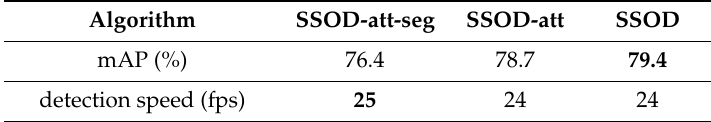
Table 5. Comparison of our algorithm and two variants in terms of mAP values (%) and detection speed (fps) on the Pascal VOC 2012 dataset. The best accuracy or detection speed is shown in